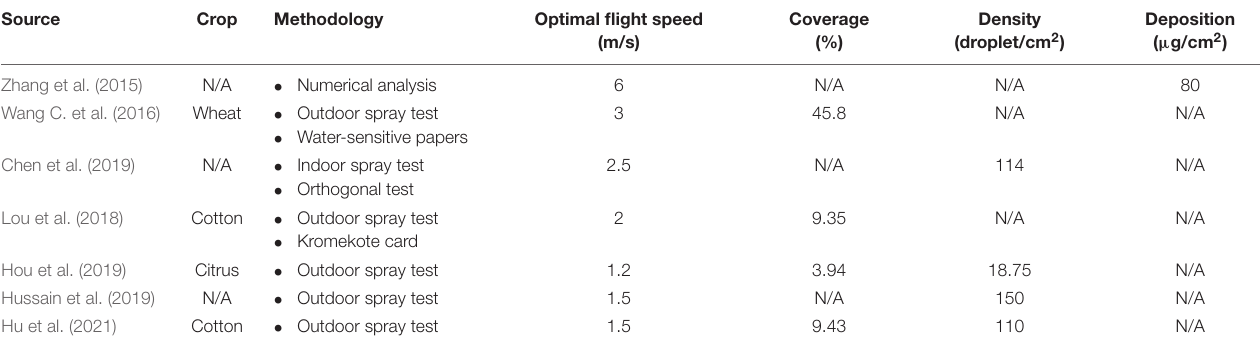
TABLE 2 | Published research on the effect of flight altitude on droplet